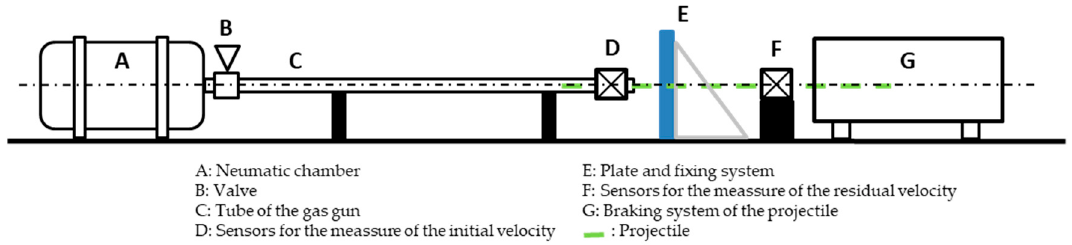
Figure 8. Experimental set-up for the ballistic characterization.